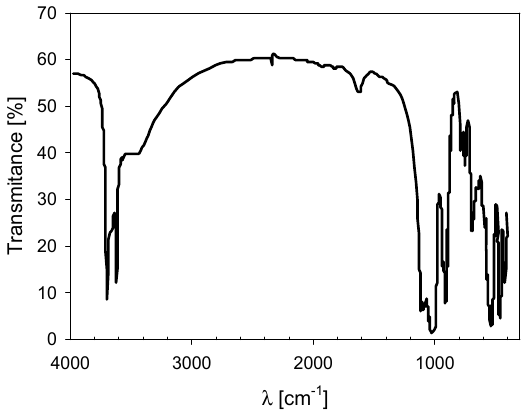
Figure 2. Fourier transform infrared (FTIR) spectrum for kaolin powder.